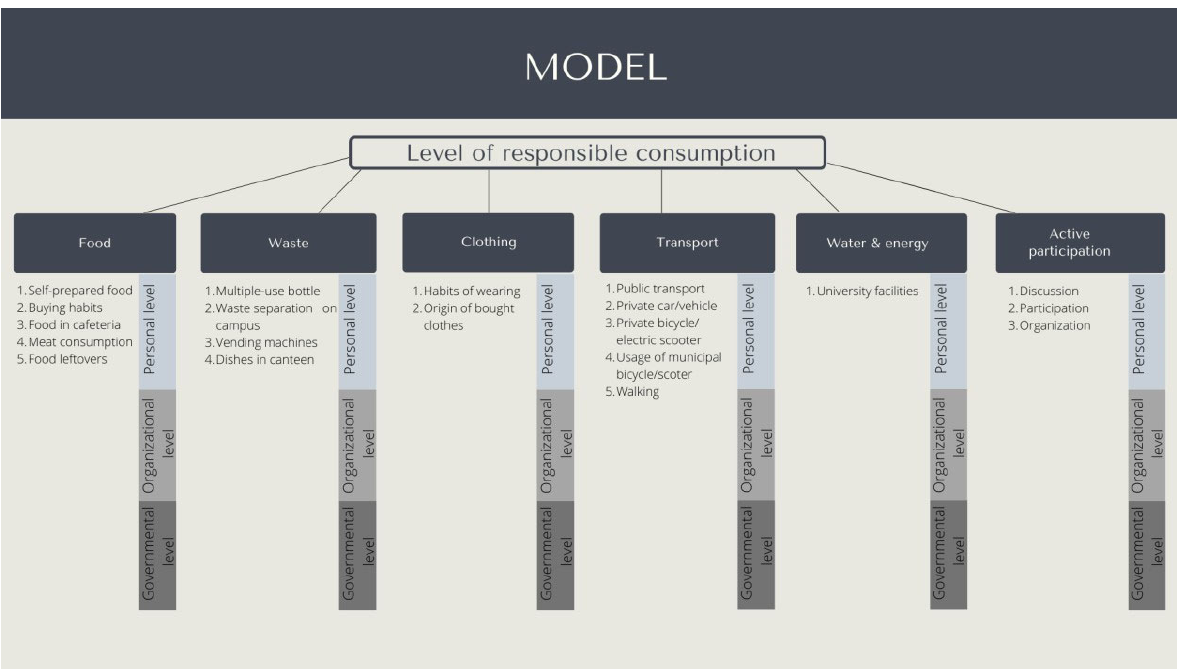
Figure 1. Illustration of model of level of responsible consumption.